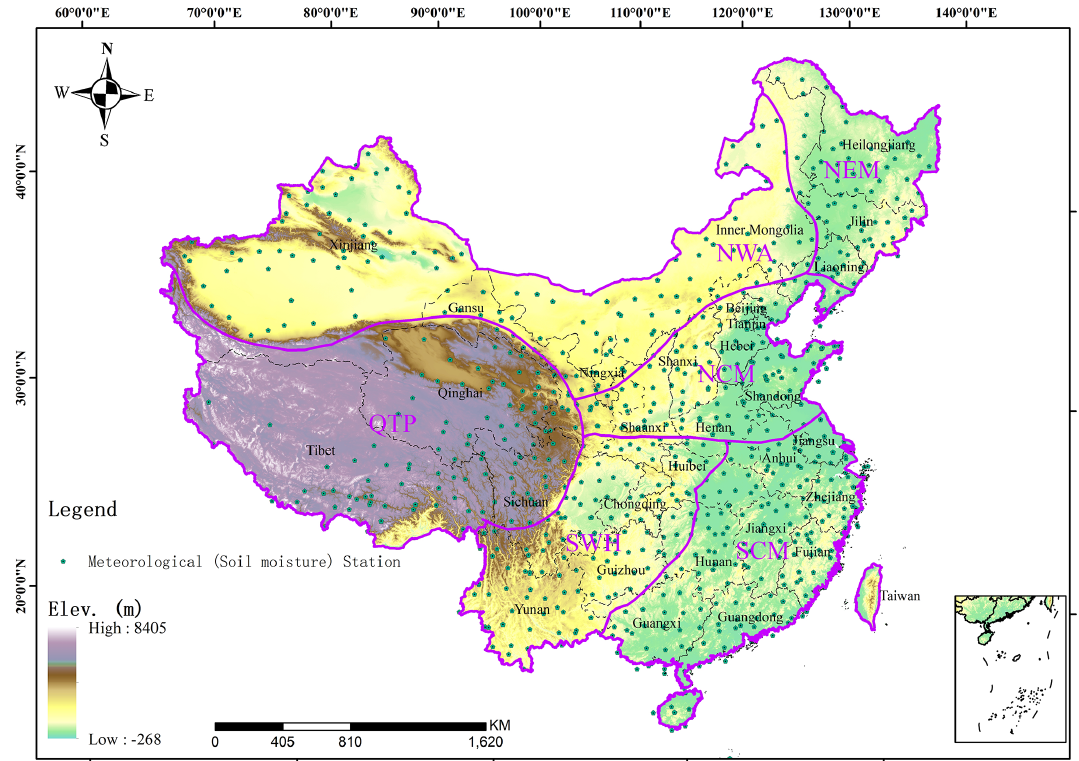
Figure 1. The geographic zoning map of the study area (delineated using the purple color) superposed with topographic information, as well as general locations for the 756 basic meteorological stations (http://data.cma.cn/, last access: 20 January 2021) that provide partial benchmark measurements for SSM and LST validation in this